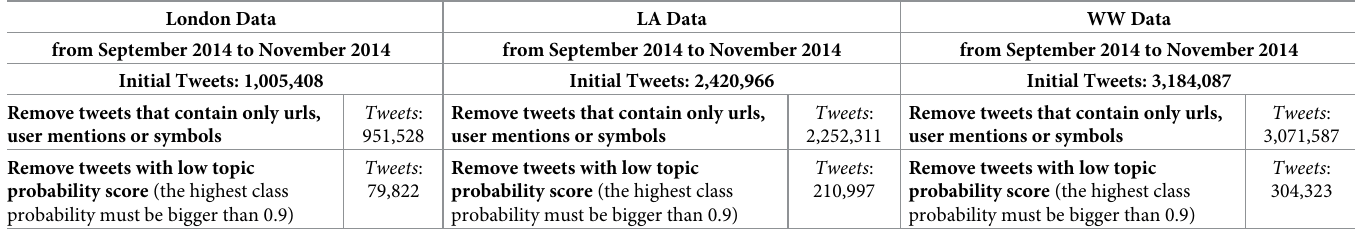
Table 6. Number of initial and usable tweets for extracting the discussion topic. London Data